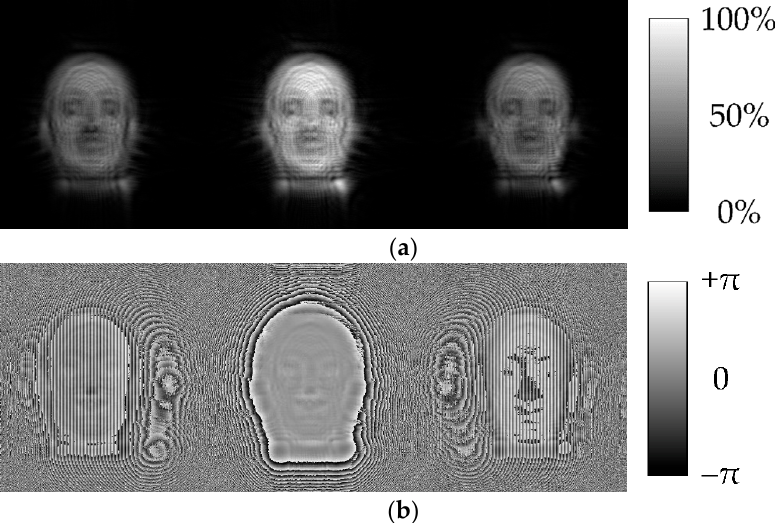
Figure 6. Fresnel spectrum from the structured fringe pattern shown in Figure 4: ( a ) the amplitude component of the spectrum with a colorbar from 0 to 100%; ( b ) the phase component of the spectrum with a colorbar from −π to + π .